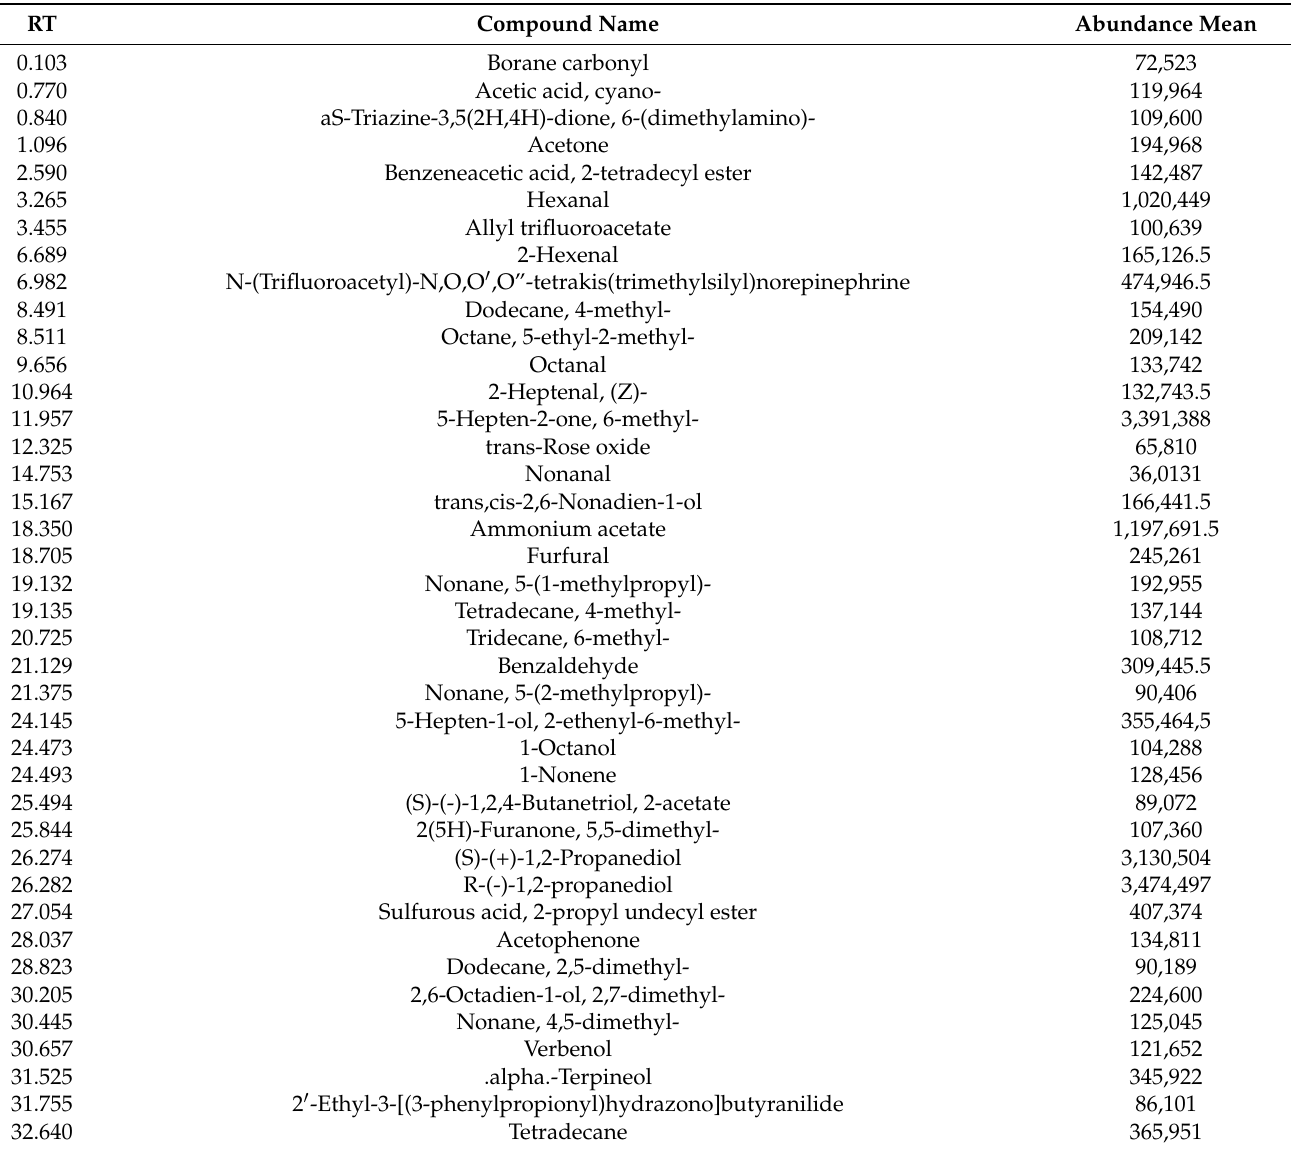
Table A11. Results for the WBL sample fingerprint determination with indication of the retention time (RT) and abundance mean for every identified